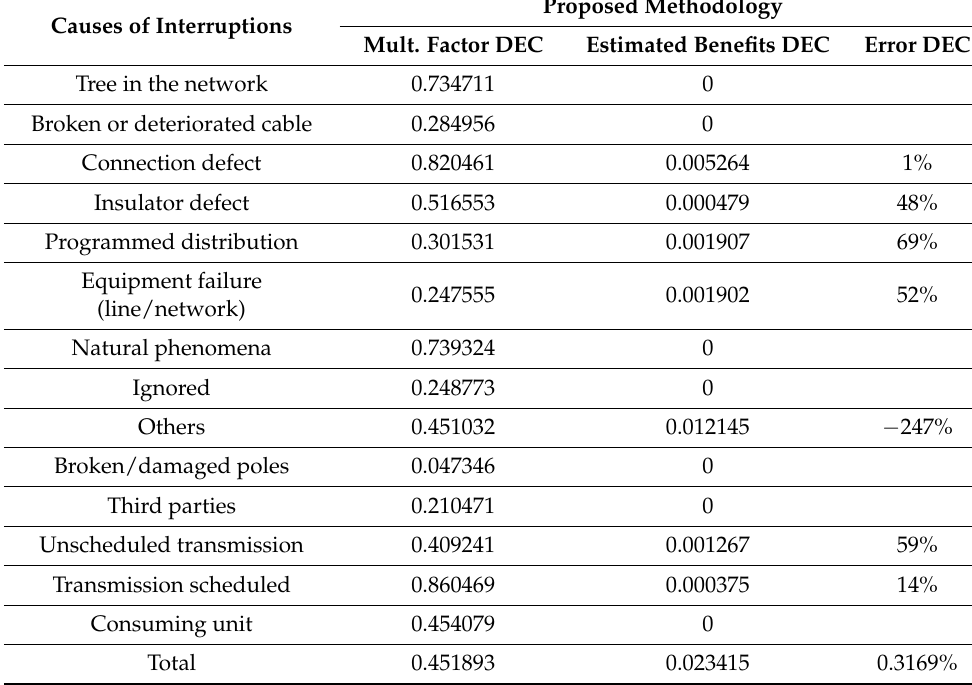
Table 6. Result of the DEC Proposed